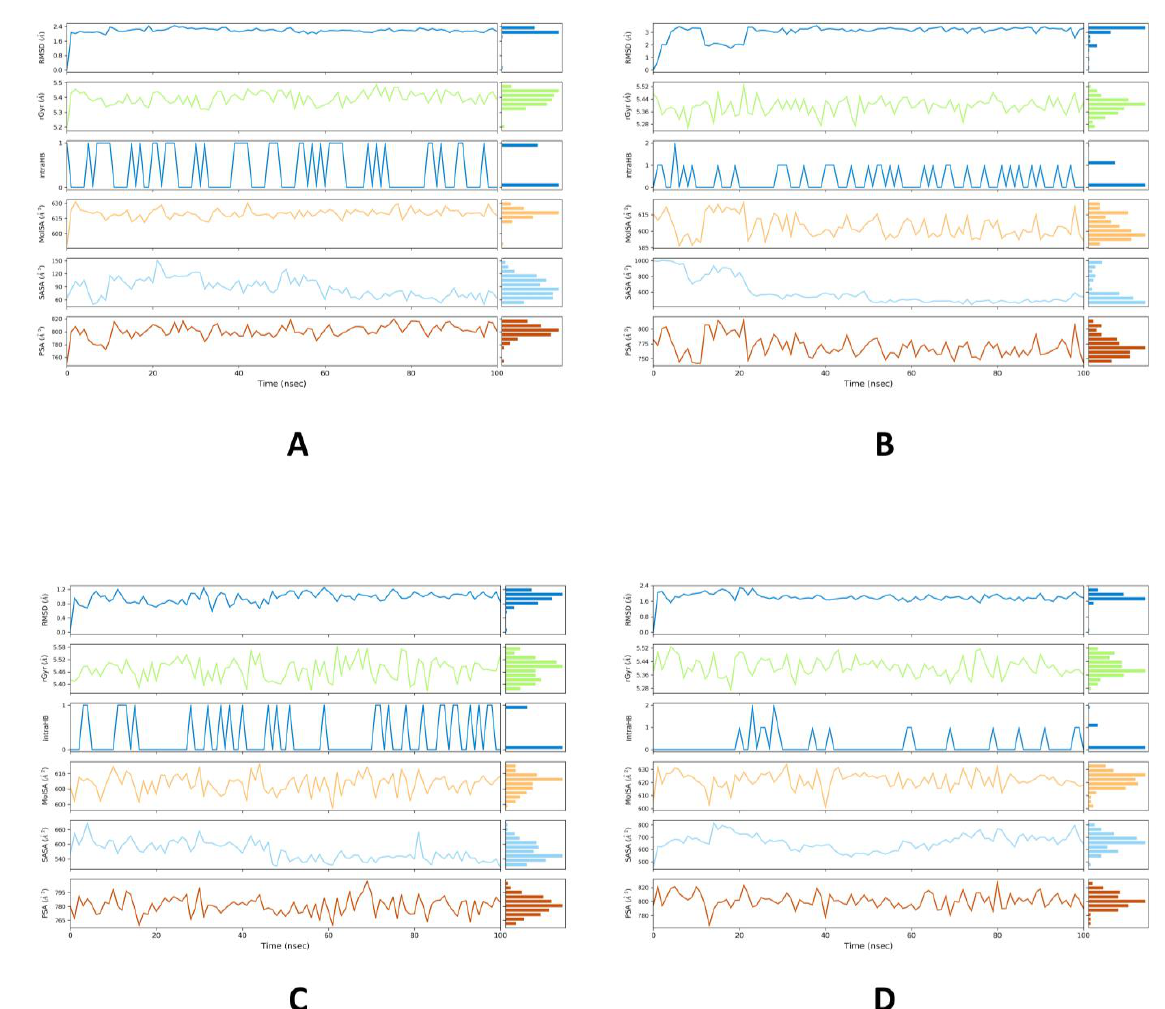
Figure 4. Ligand properties for casuarinin with 4YAY ( A ), 4DLI ( B ), 1HW9 ( C ), and 1B09 ( D ) proteins, such as RMSD, the radius of gyration (rGyr), intramolecular hydrogen bonds (intraHB), molecular surface area (MolSA), solvent accessible surface area (SASA), polar surface area (PSA) on interacting with protein during MD simulation.